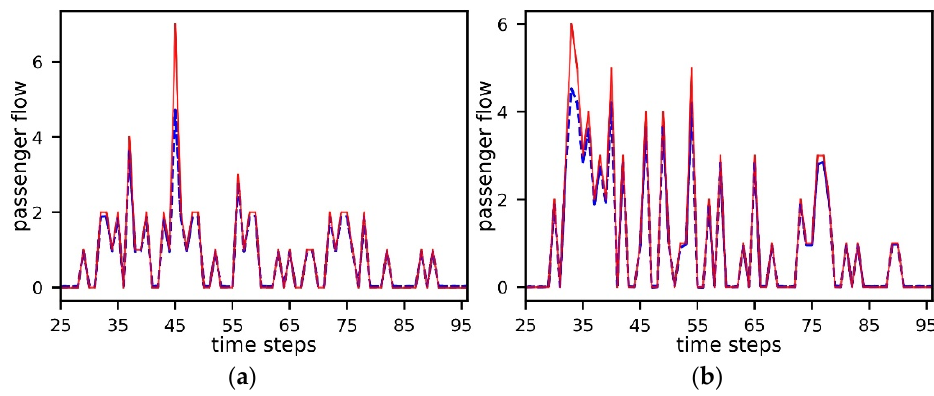
Figure 10. The examples of forecasting curves and the ground-truth curves for hub to suburban OD flow: ( a ) weekdays; ( b ) weekends.